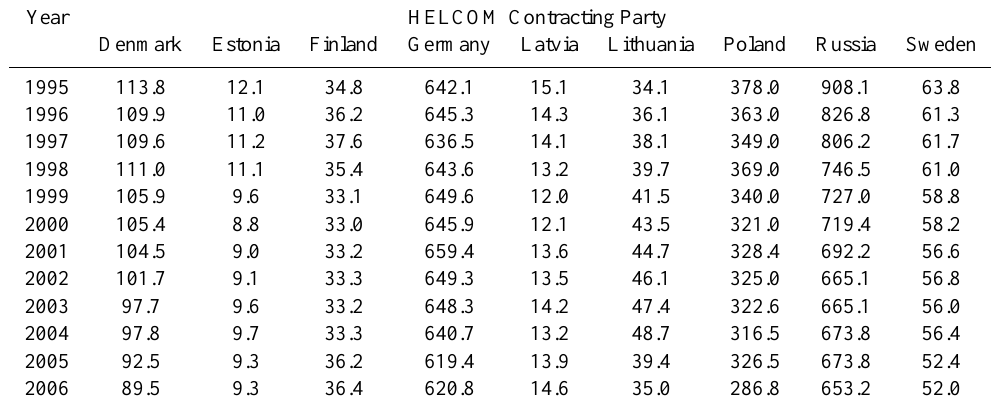
Table 2. Annual emissions of ammonia in HELCOM Contracting Parties in the period 1995 – 2006. Units:GgNH 3 per